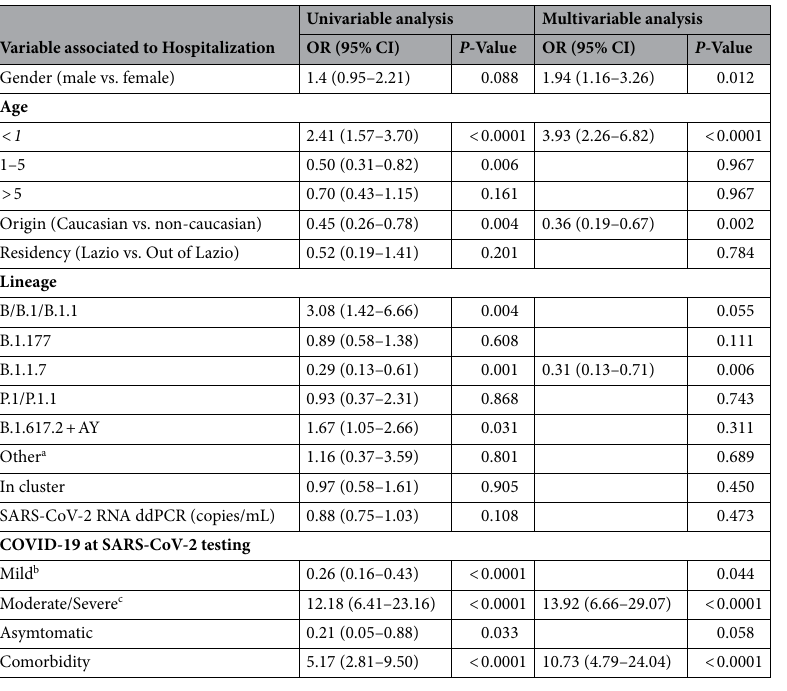
Table 3. Multivariable logistic regression analysis of factors associated with Hospitalization. a